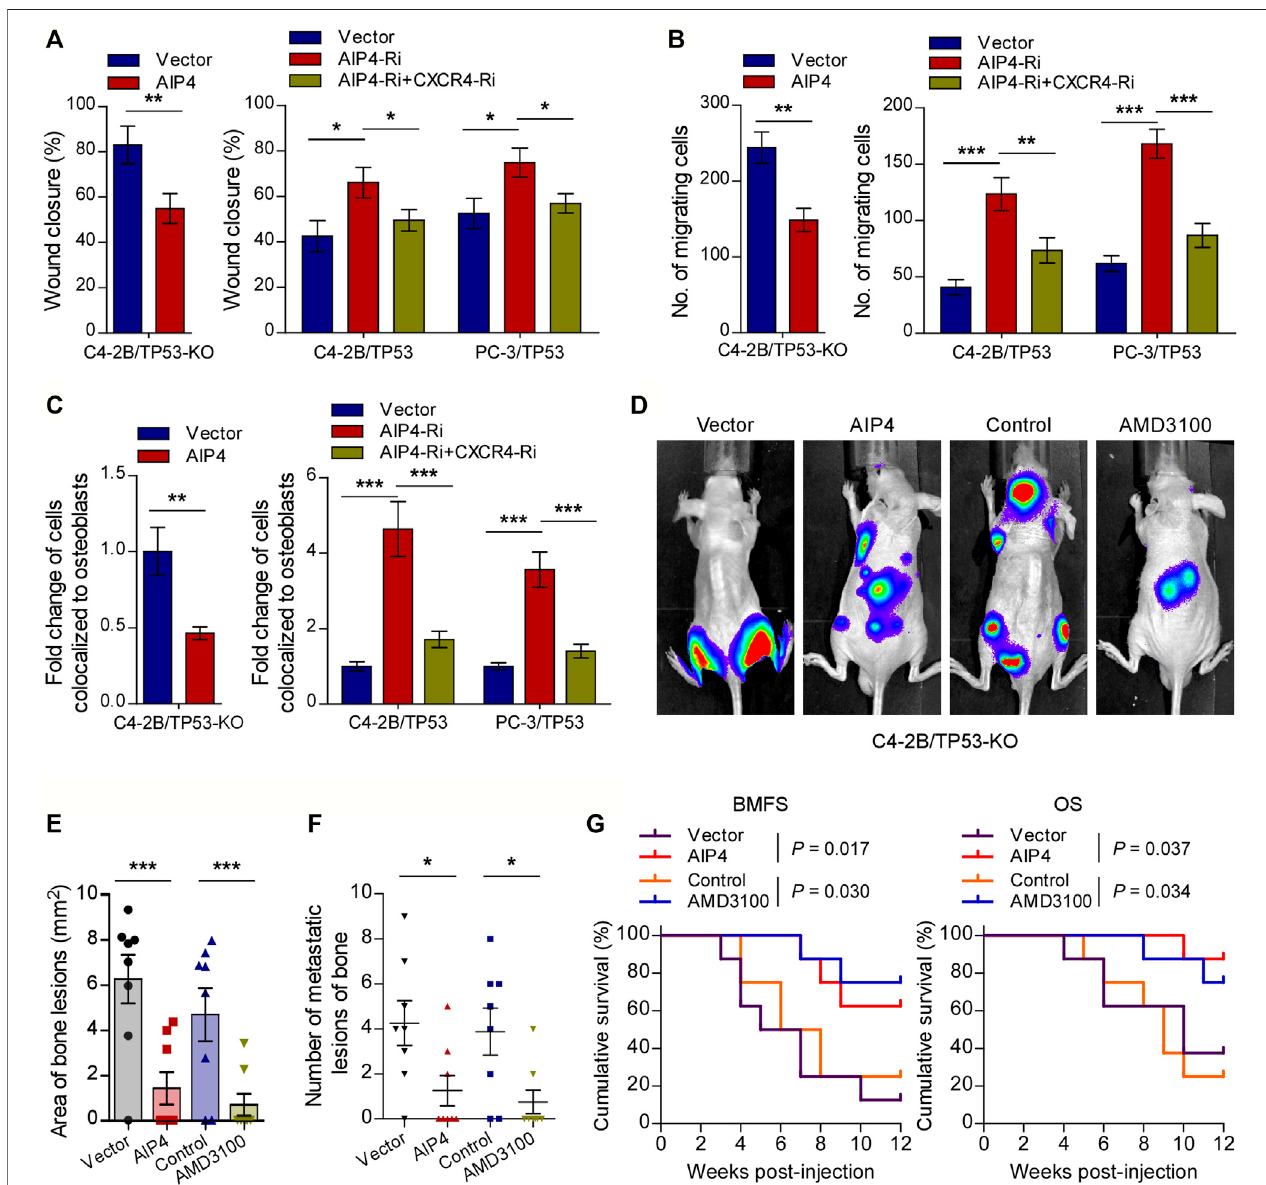
FIGURE 5| CXCR4 inhibitor and AIP4 plasmid transduction reverse the pro-bone metastasis effects of TP53 deletion. (A) Wound-healing assays for the indicated cell lines. Wound closure was photographed at 24 h after wounding. Tumor cells were cultured in MC3T3-E1 condition medium. (B) Quanti fi cation of the migration of indicated cells in transwell assays. Tumor cells (top chamber) were co-cultured with primary osteoblasts (bottom chamber) in the transwell plate. (C) Quanti fi cation of in vitro competitive colocalization assays for the indicated cells. Error bars represent the means ± SD. (D) Representative BLI images of bone lesions from mice inoculatedintracardiallywithindicatedtumorcellsineachexperimentalgroup( n (cid:1) 8/group).MicewereadministeredwithintraperitonealinjectionofAMD3100(Plerixafor, AbMole, 5 mg/kg, every 2 days). (E) Histomorphometric quanti fi cation of tumor area in hind limbs from each experimental group. (F) Numbers of metastatic lesions in hind limb bones from each mouse in two groups. Error bars represent the means ± SEM. (G) Kaplan-Meier curves of bone metastasis-free survival (BMFS) and overall survival (OS) in mice from each experimental group (log-rank test). * p < 0.05. P values were based on t -test unless otherwise indicated.